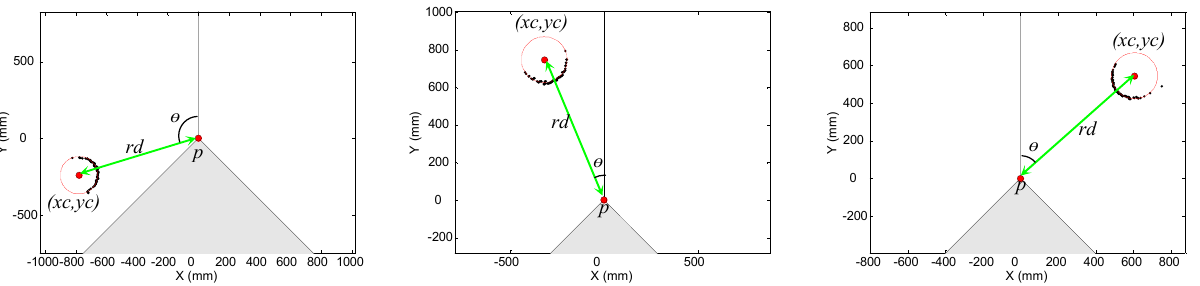
Figure 10. Circular target location for three different